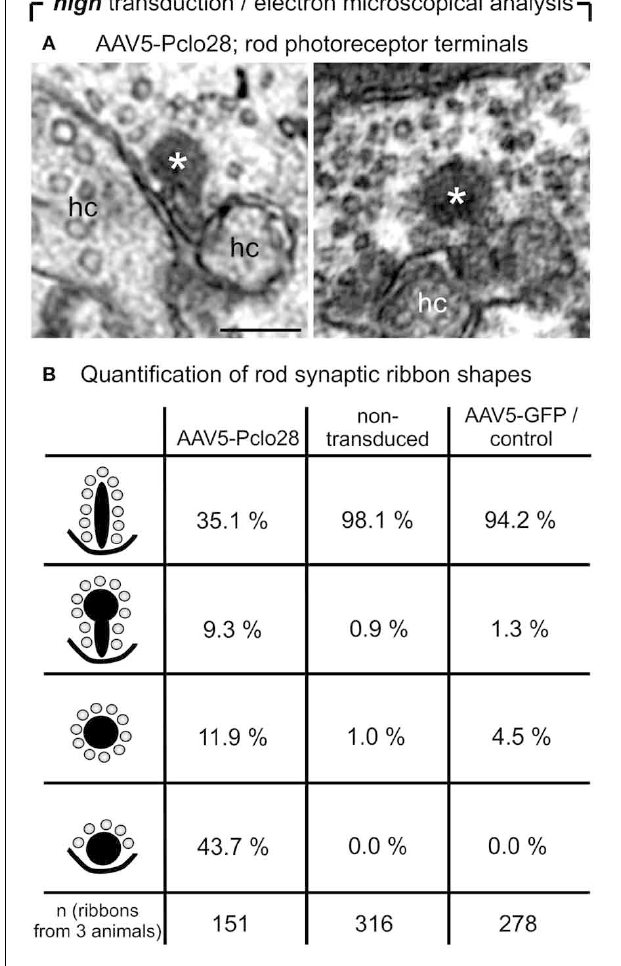
FIGURE 6 | Ultrastructural analysis of C57BL/6 rod photoreceptor ribbon synapses in retinal areas with high AAV5-Pclo28-transduction rates. (A) Representative electron micrographs of rod photoreceptor terminals from a highly AAV5-Pclo28-transduced retinal area, processed for best tissue preservation. The asterisks demarcate spherical, membrane-associated ribbon material. (B) Quantification of four different shapes of ribbon profiles—plate-shaped, club-shaped, floating and membrane-attached spheres—in rod photoreceptor terminals from highly AAV5-Pclo28-transduced, non-transduced, and AAV5-GFP-transduced (control) retinal areas. hc: horizontal cell. Scale bar in (A) : 0.2 μ